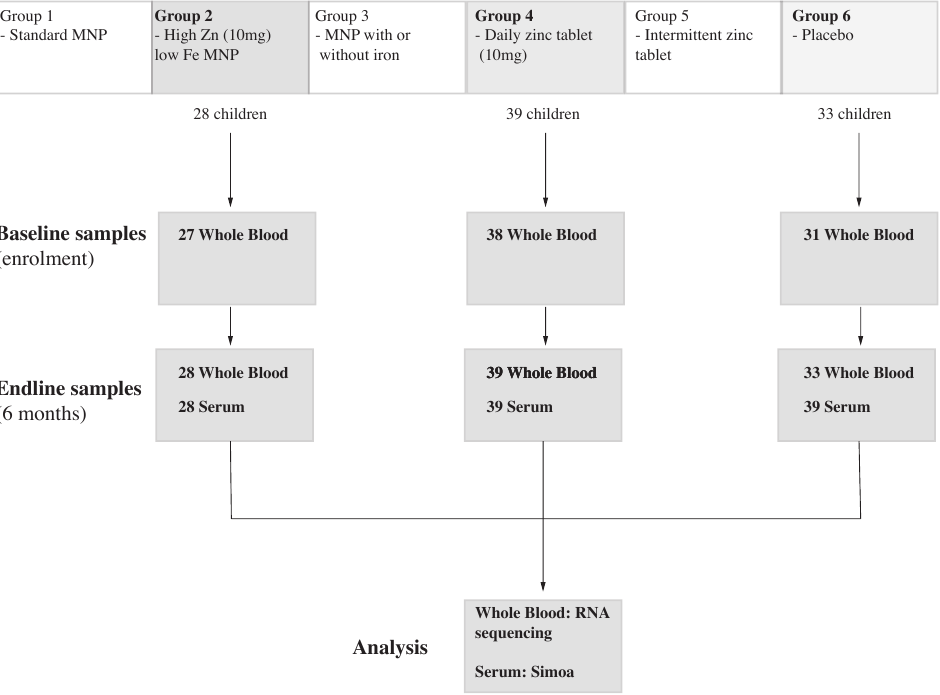
Figure 1. Study flow for the transcriptomic and immunologic evaluation of trial participants. Three study arms (Group 2, Group 4 and Group 6) were selected from the main ZIPT trial, reflecting high-dose zinc delivered as either micronutrient powders, dispersible tablets or placebo. The number of samples which were analyzed by RNA sequencing or Simoa is shown at each timepoint.